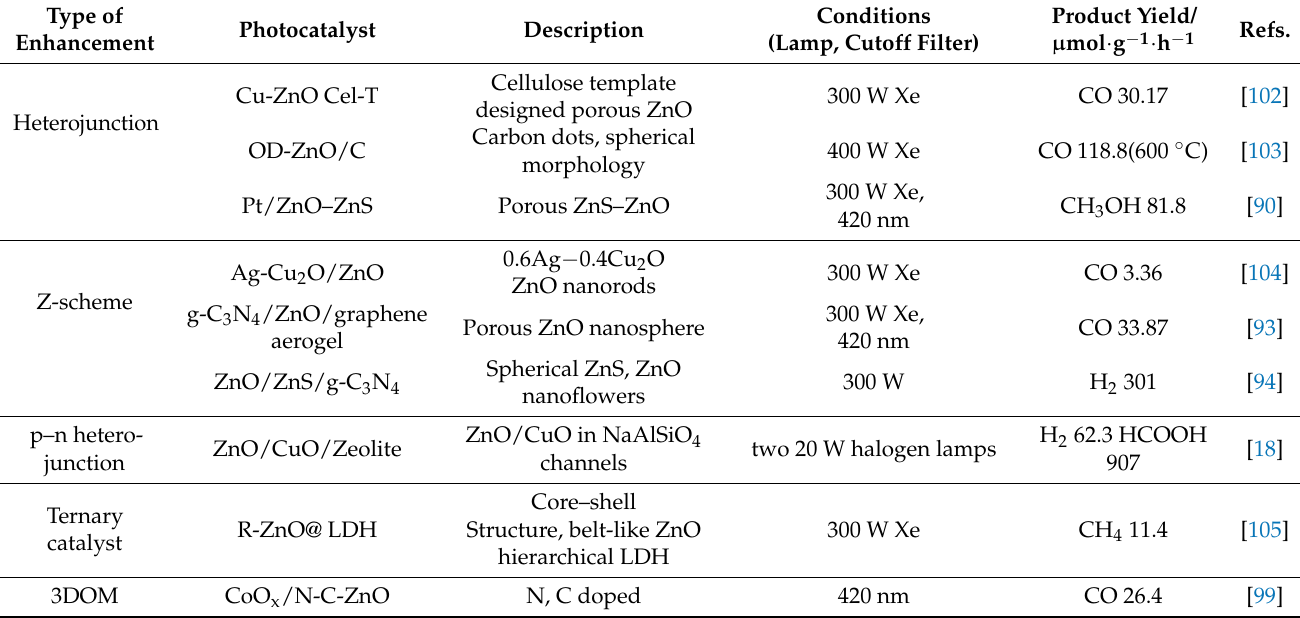
Table 3. Summary of the recent results on the photoreduction of CO 2 by WO 3 -based